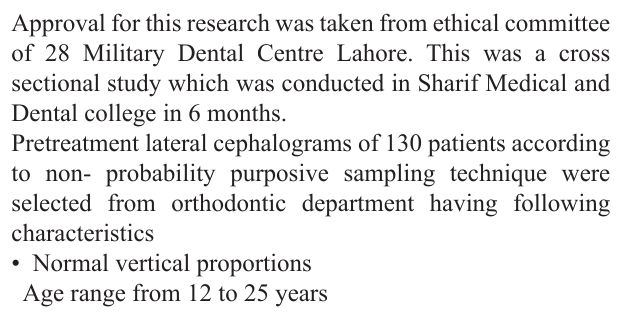
using student’s t test Table-III.